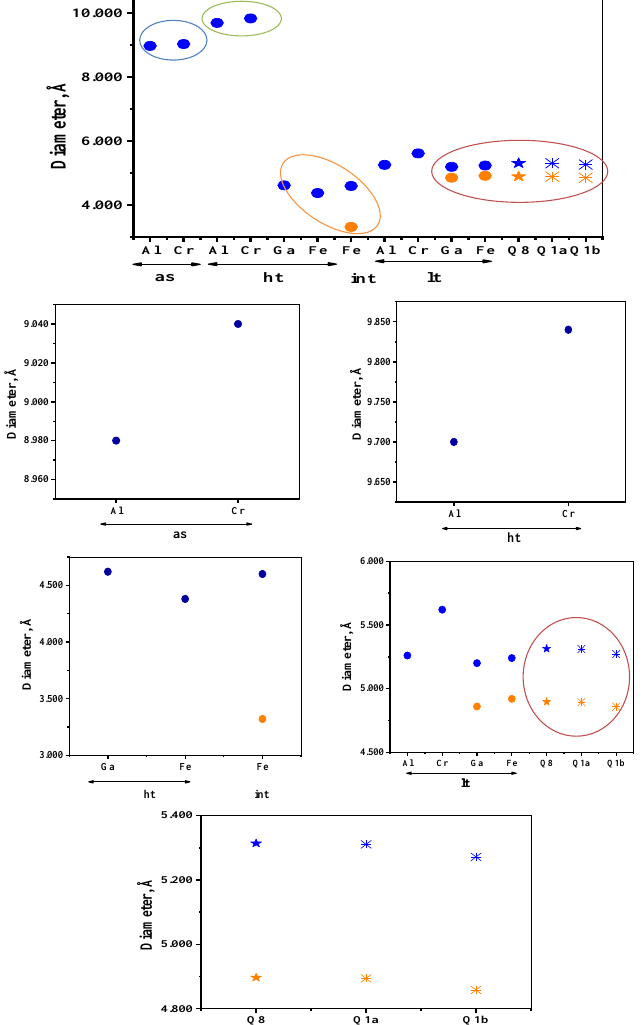
Figure 7. Diameters of voids in the framework of phases I–VI (Table 1). The asterisk denotes the MIL-53(Fe)/GO sample: Q1a is MIL-53(Fe) in MIL-53(Fe)/GO with 200 at peak 2 θ = 8.93 ◦ and Q1b is MIL-53(Fe) with 200 at peak 2 θ = 9.25 . The star symbol denotes the MIL-53(Fe) sample (Q8) obtained.